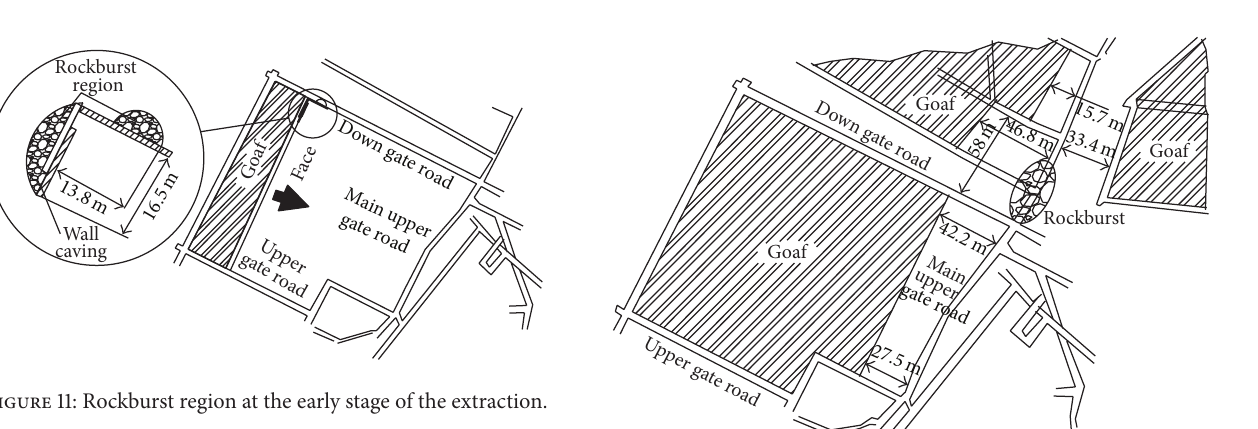
Figure 10: Electromagnetic radiation monitoring results at the early stage of extraction.